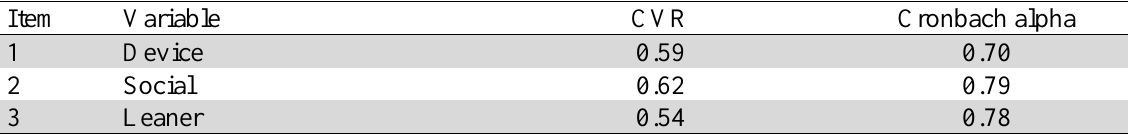
The summary of CVR and Cronbach